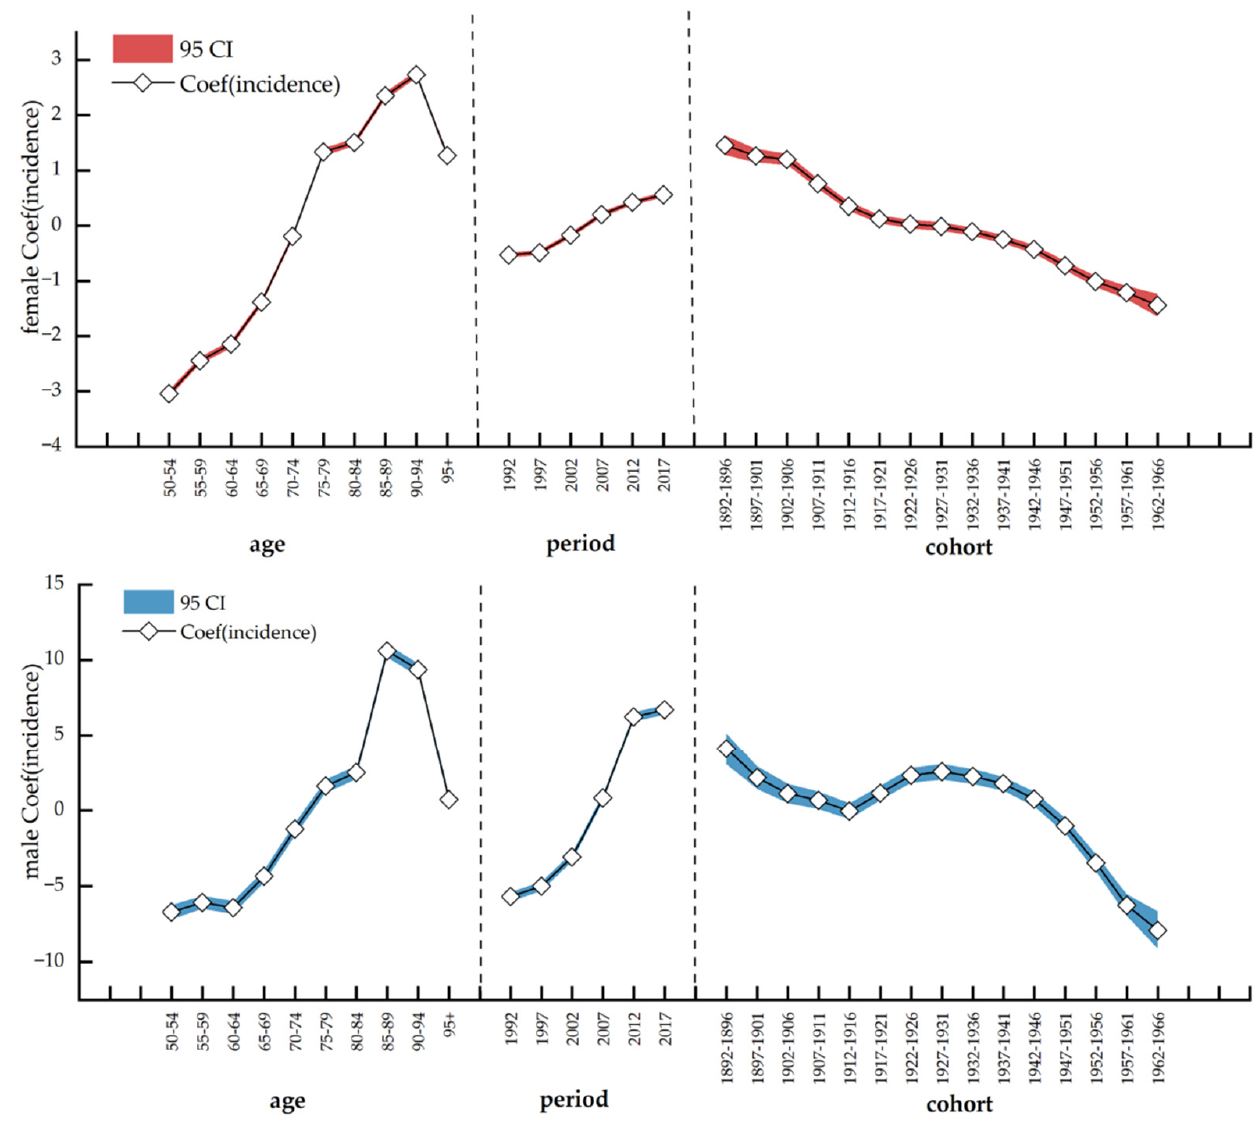
Figure 5. APC model analysis of lip and oral cavity cancer incidence among females and males in China. Note: APC model, Age–Period–Cohort model; Coef: coefficient; and CI: confidence interval.